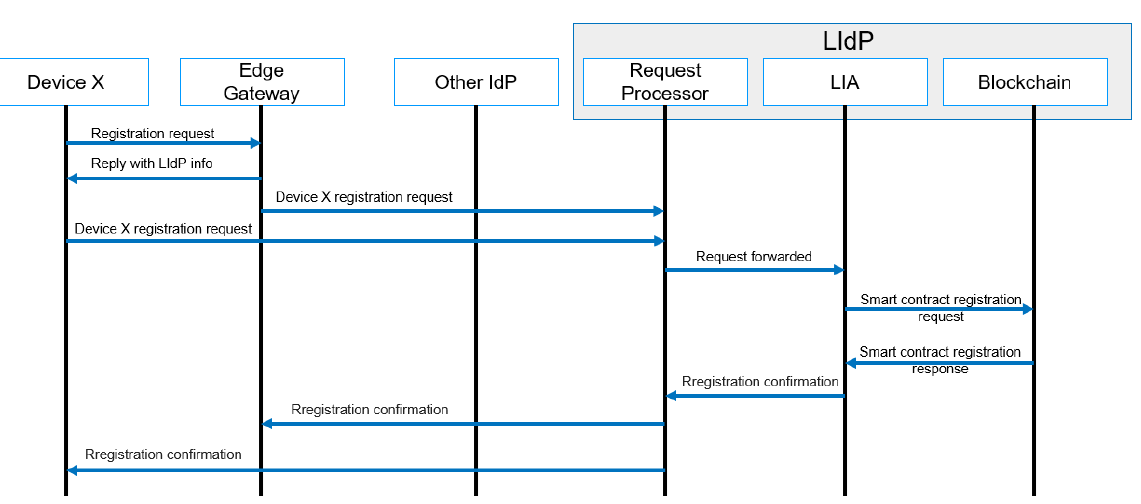
Figure 8. Registration process message flow.